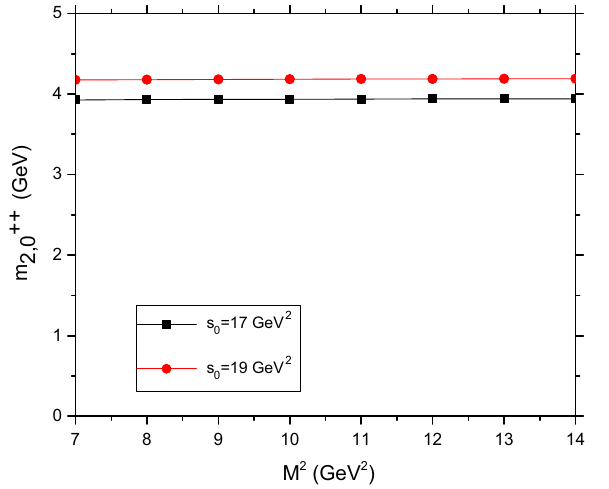
Fig. 3 Borel parameter dependence of J PC = 0 ++ meson mass from (cid:10) ( 2 ) μναβ for different s 0 values